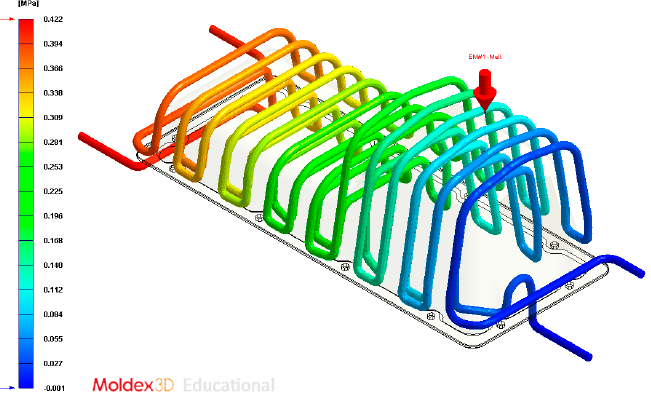
Figure 29. Pressure (MPa) of the coolant along the cooling system, Case C.